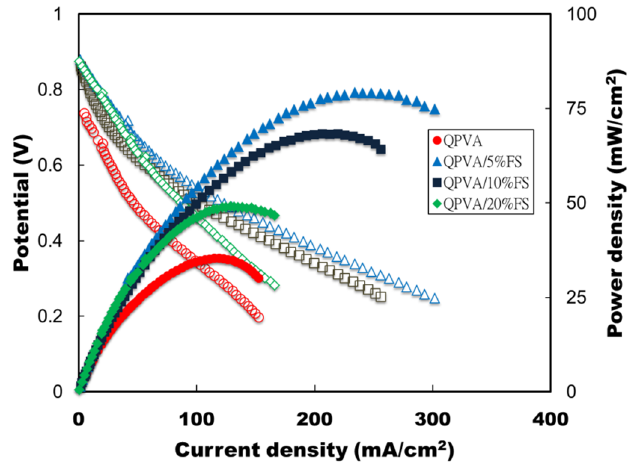
Figure 13. Ethanol cell performance of pristine QPVA and the QPVA/FS nanocomposite membrane at 60 °C. at 60 ˝